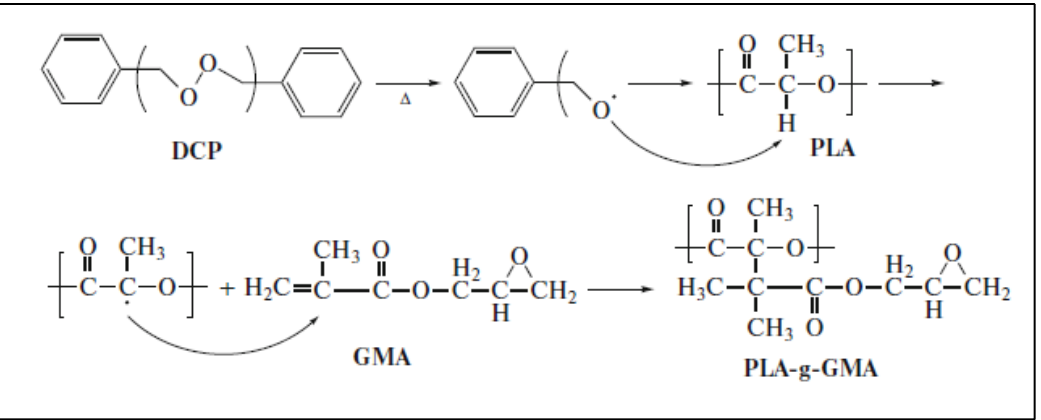
Figure 14. Reaction scheme for the grafting of GMA on PLA backbone (from Gu et al. [69], copyright Springer Nature, reproduced with permission).